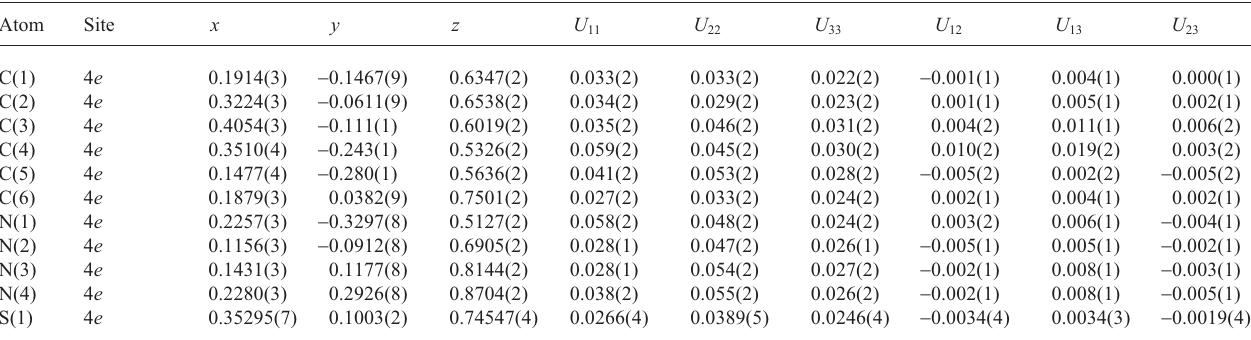
Table 3. Atomic coordinates and displacement parameters (in Å 2 )